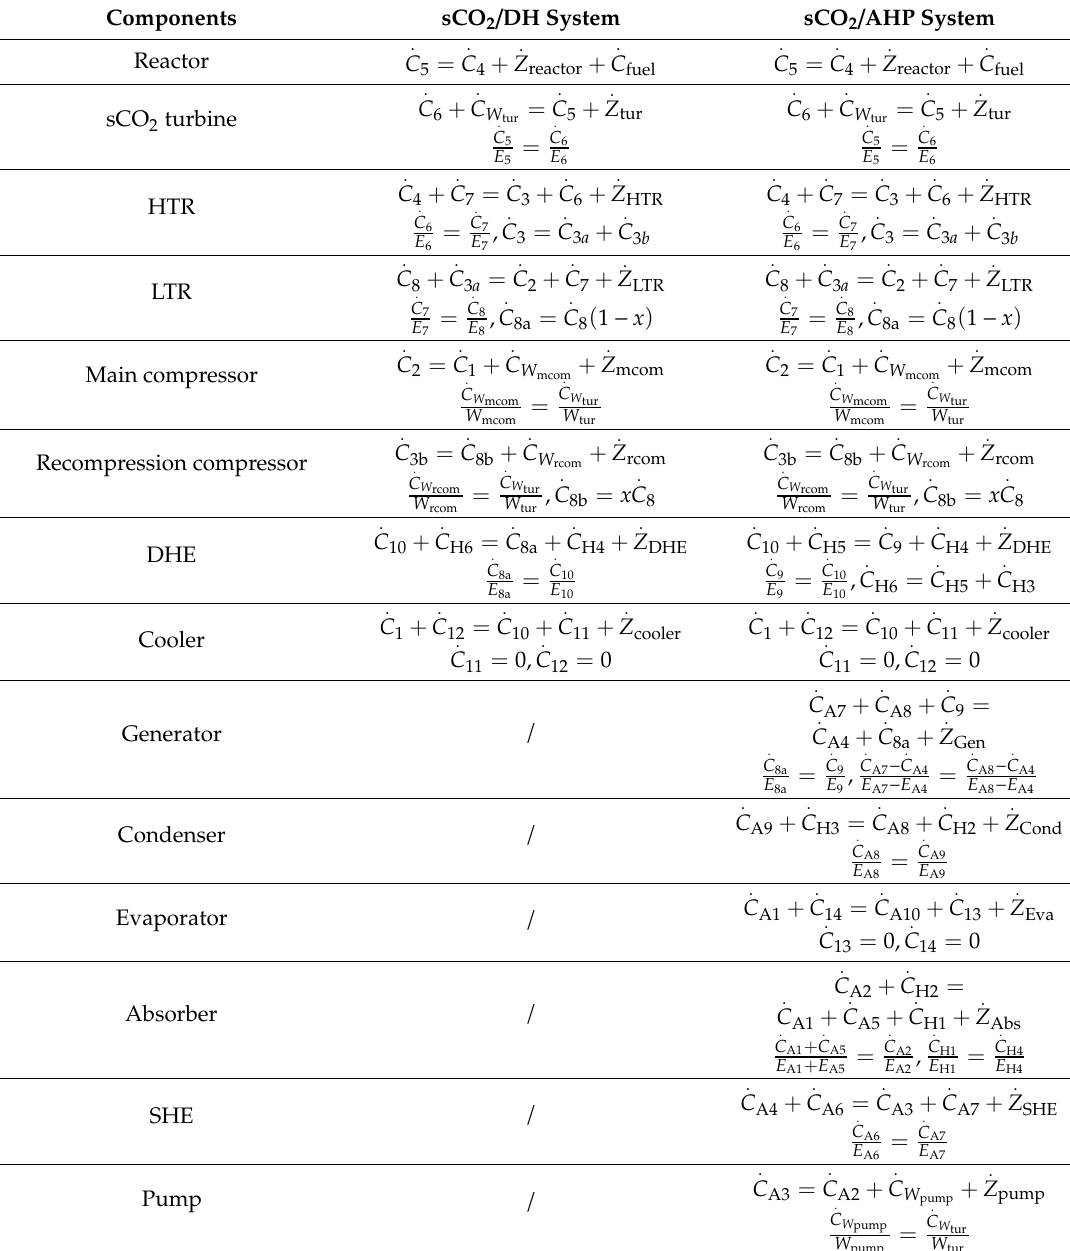
Table 5. Cost balance equations and auxiliary equations for the combined